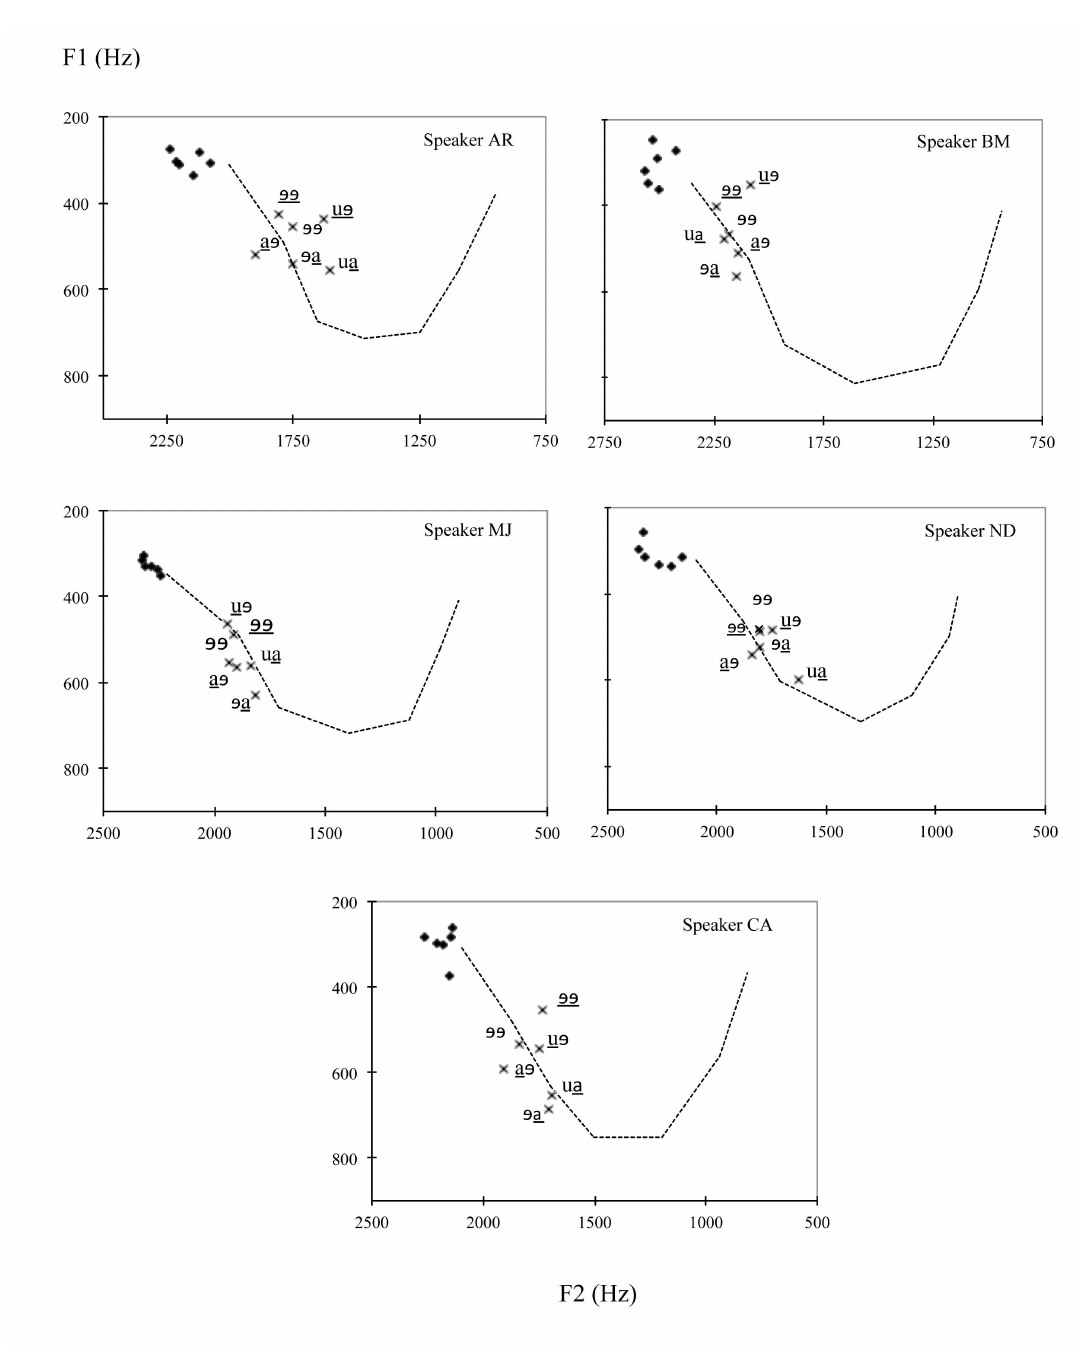
FIGURE 5. F1 x F2 values for initial and final [j] (filled circles), intervocalic [j] (crosses) and the vowels [i, e,  , a,  , o, u] for each of the Majorcan speakers AR, BM, MJ, ND and CA. The flanking vowels of the [VjV] sequences are given in phonetic transcription with the stressed vowels